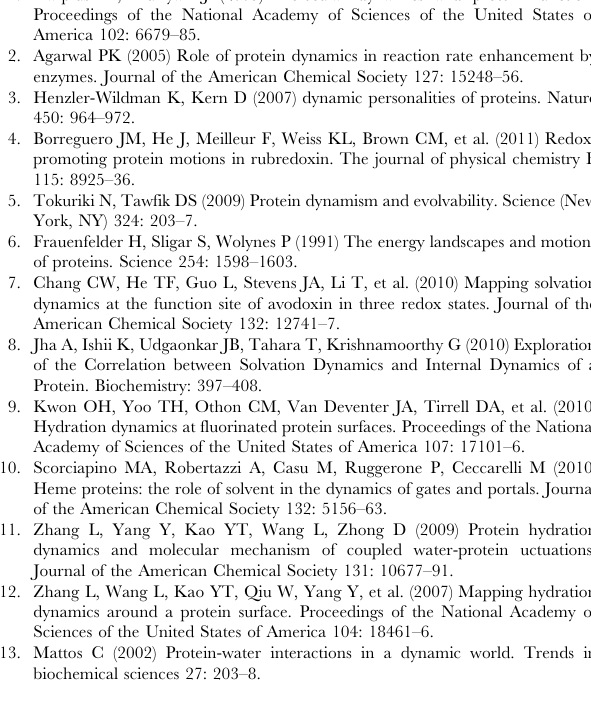
{ s E p ) for eight tot